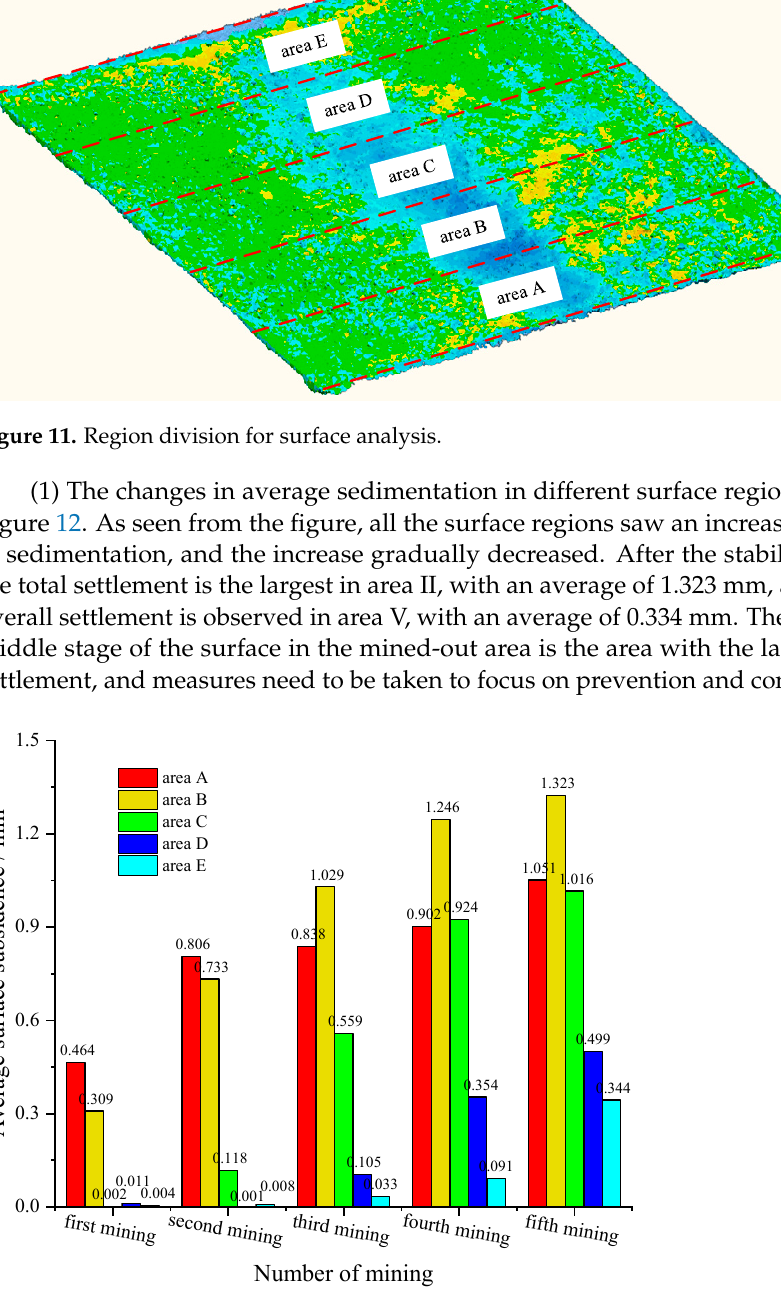
Figure 12. Histogram of average sediment volume change in different regions of the surface. (2) The radar map of the average sedimentation for the different surface regions is shown in Figure 13. With the exception of area I, each area settles when the coal seam corresponds to the previously mined area, and the amount of advanced settlement caused by coal seam mining in areas II to V is 0.309 mm, 0.118 mm, 0.105 mm, 0.091 mm, respectively, with an overall decreasing trend being observed. At the same time, during the third mining operation, area V shows a mild response, indicating that as the range of the mined-out area increases, the degree of surface subsidence advance that is caused by the continuously advancing working surface is gradually reduced, but the advance impact range gradually